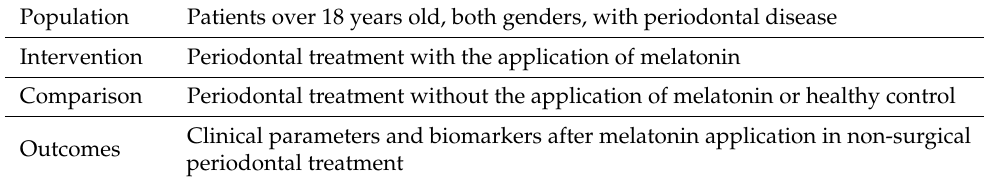
Table 1. PICO strategy for focus question formulation. Population Patients over 18 years old, both genders, with periodontal disease Intervention Periodontal treatment with the application of melatonin Comparison Clinical parameters and biomarkers after melatonin application in non-surgical Outcomes periodontal